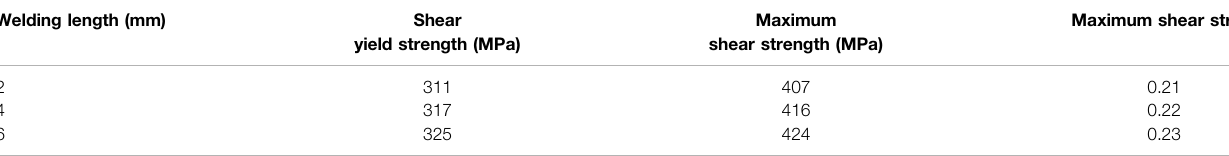
TABLE. 3 | Shear test data of zirconium alloy welds with different welding lengths. Welding length